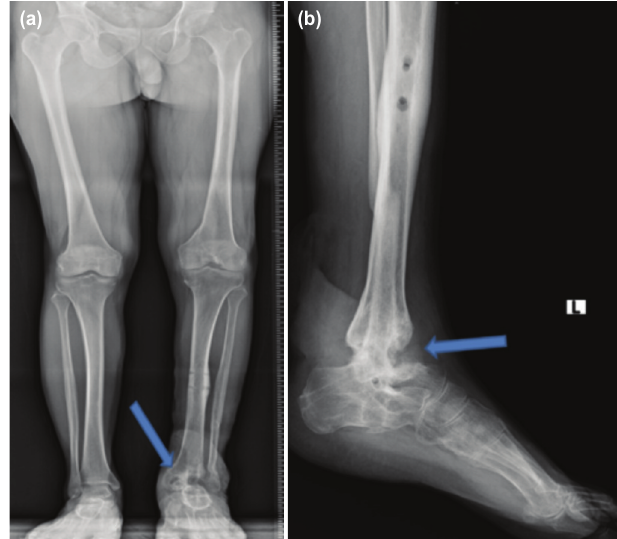
(a, b) Patient 3 after nail removal with arthrodesis site union at 24 months of follow-up. Fig. 4: